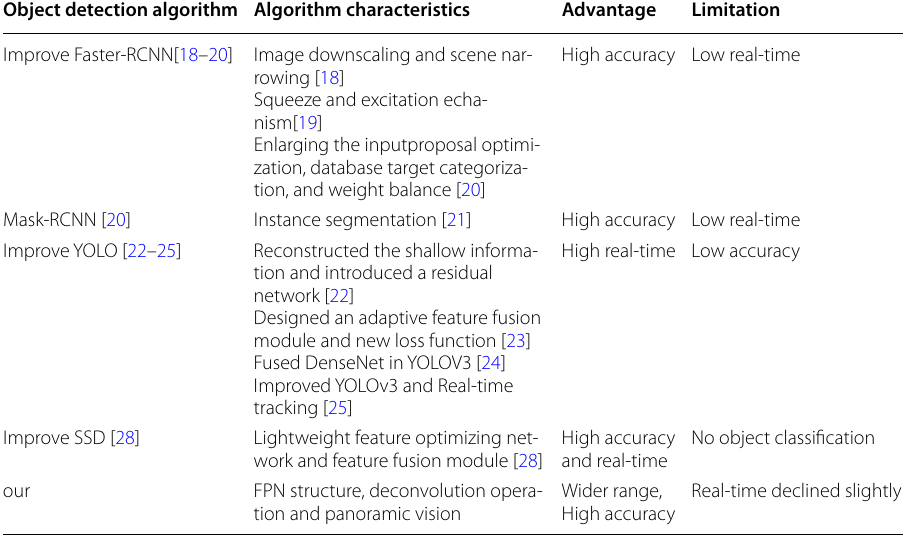
Table 1 Comparison of various water surface object detection algorithms Object detection algorithm Algorithm